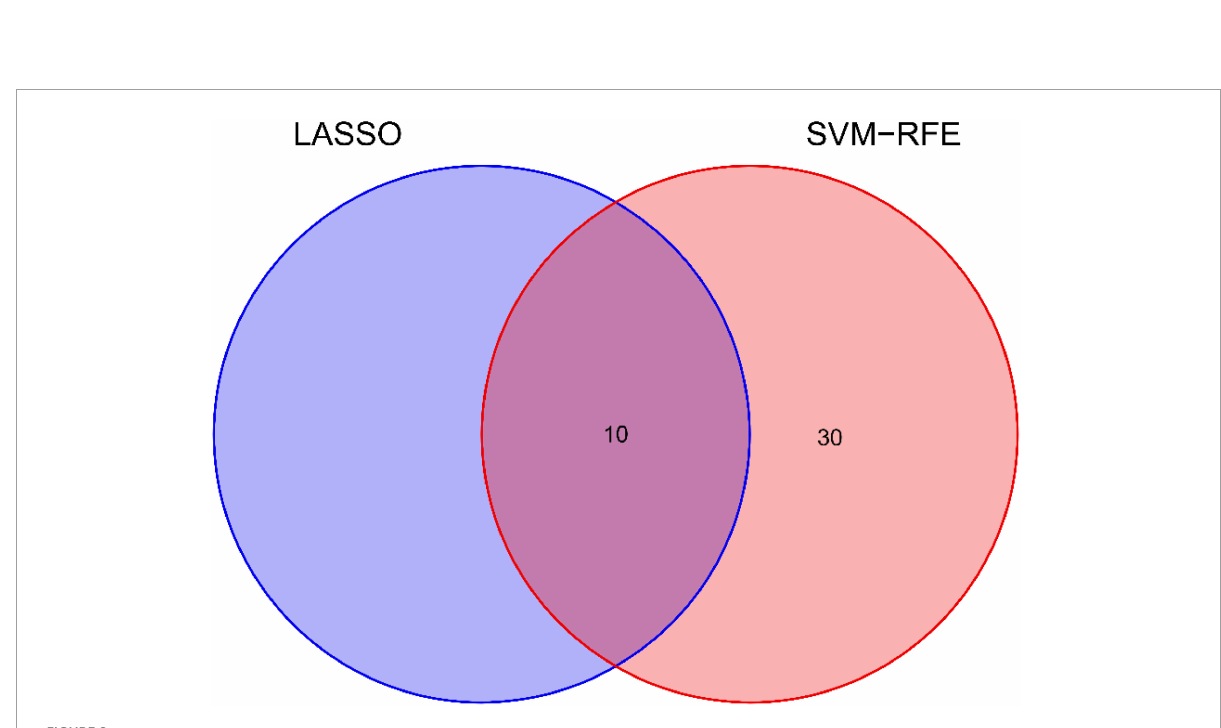
FIGURE8 Venn diagram shows the minimum absolute shrinkage and ten diagnostic markers that the selection operator shares with the SVM-RFE